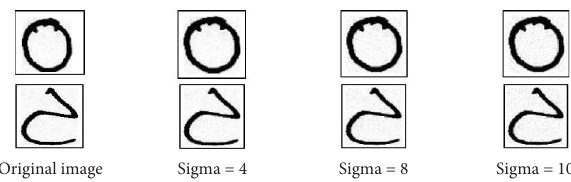
Figure 7: Example of images applying Gaussian noise.